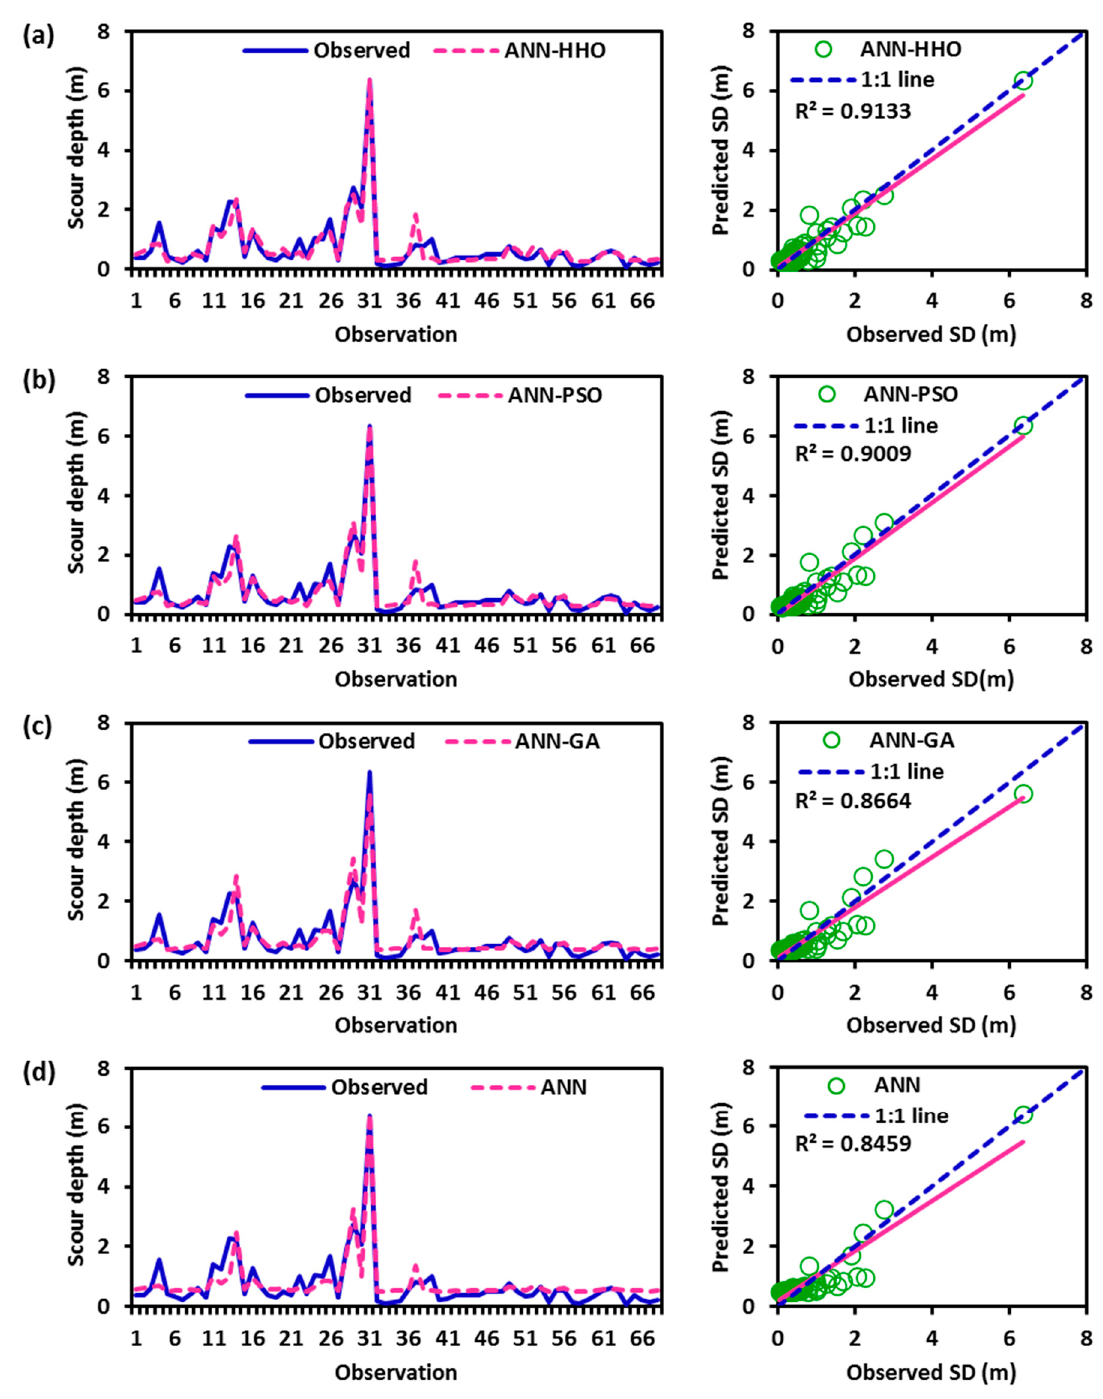
Figure 4. Line and scatter plots of ( a ) ANN-HHO, ( b ) ANN-PSO, ( c ) ANN-GA, and ( d ) ANN models during the training period.